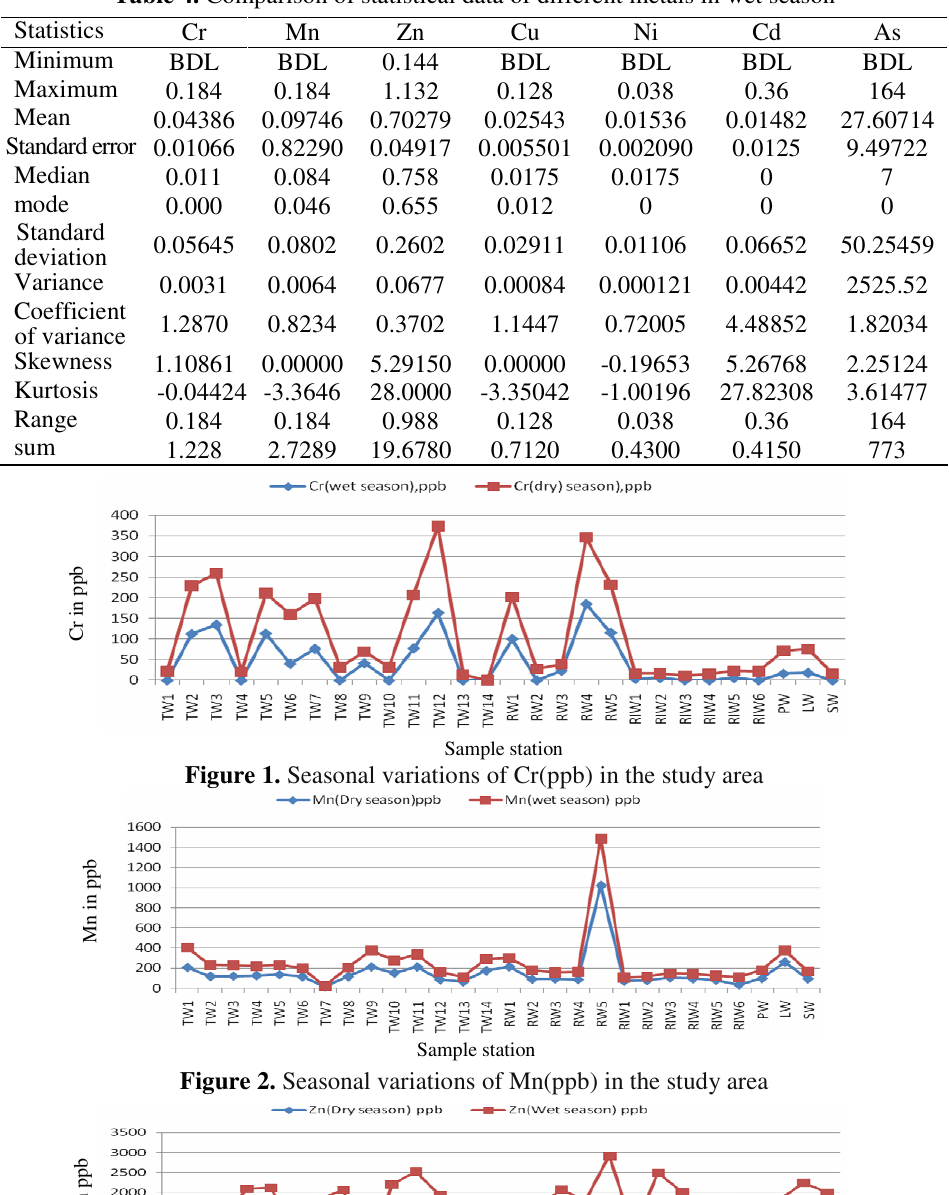
Table 4. Comparison of statistical data of different metals in wet season